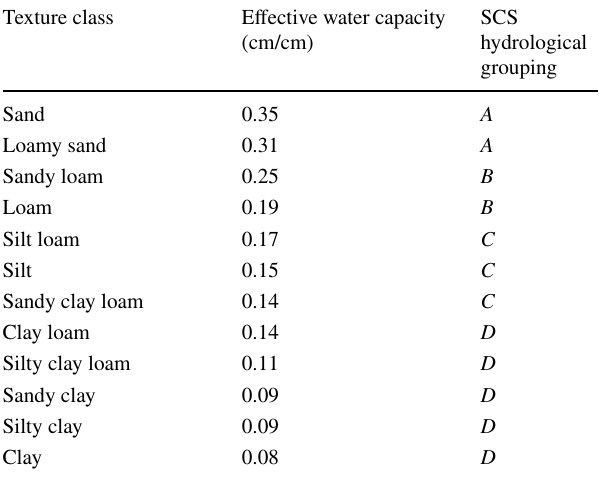
Table 5 Hydrological soil properties classified by soil texture. (Reproduced with the permission from Rawls et al.